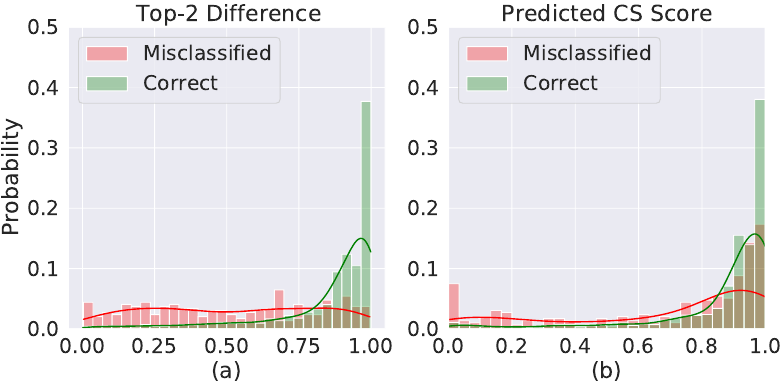
Figure 8. ( a ) Distribution of differences between the two highest values in the classification output vector for correct classified samples (green bars) and misclassified ones (red bars). ( b ) Distribution of predicted CS scores for correct classified samples (green bars) and misclassified ones (red bars). Both distributions were computed with D 6 test set.